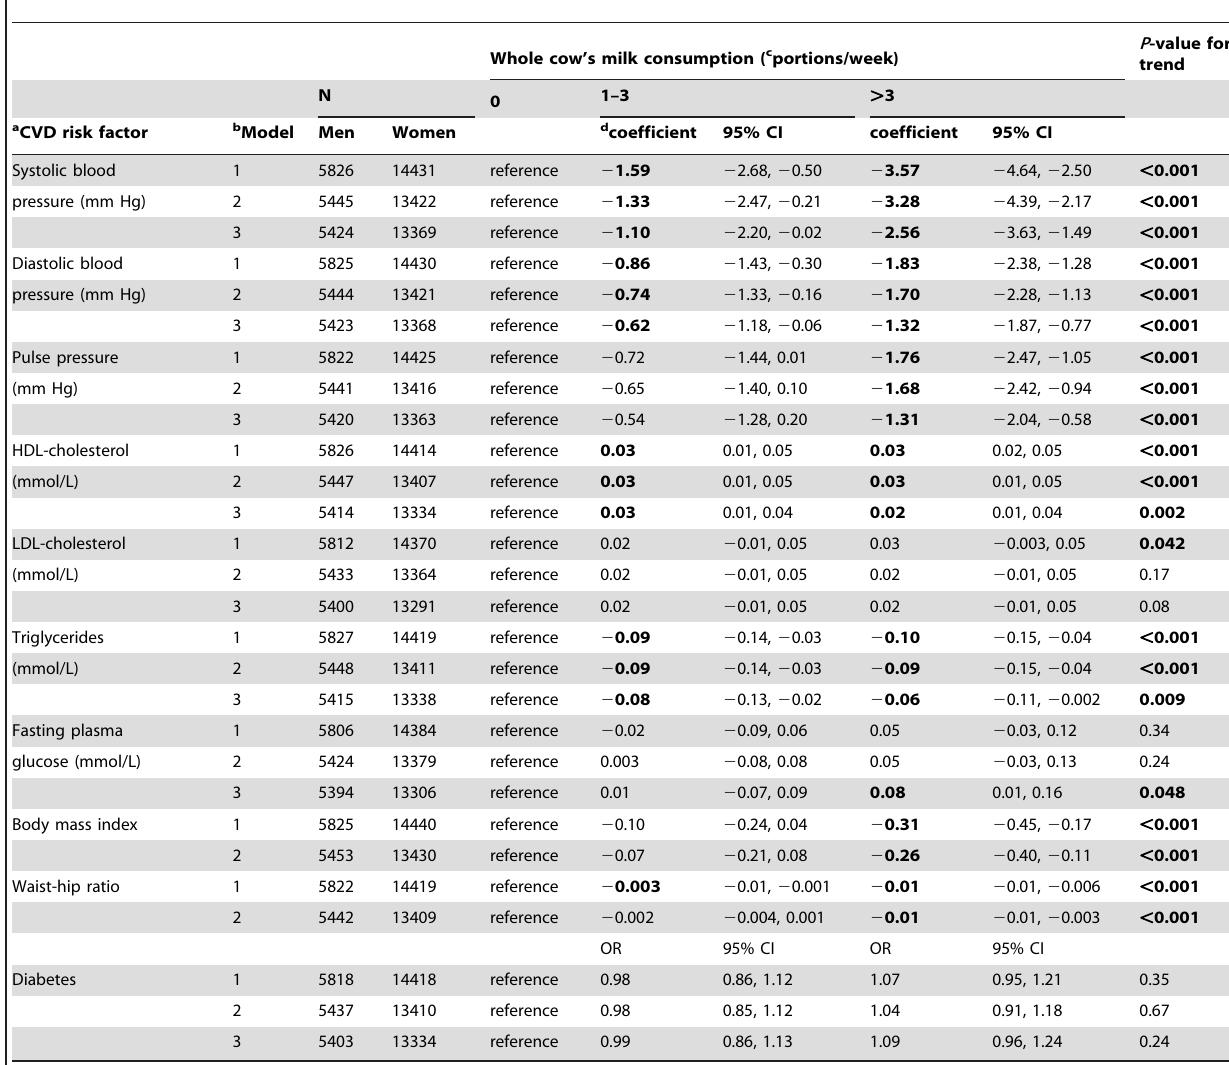
Table 3. Adjusted Associations of Whole Cow’s Milk Consumption with CVD Risk Factors in Older Chinese (5853 men and 14,482 women) in Phases 1 and 2 of the Guangzhou Biobank Cohort Study,